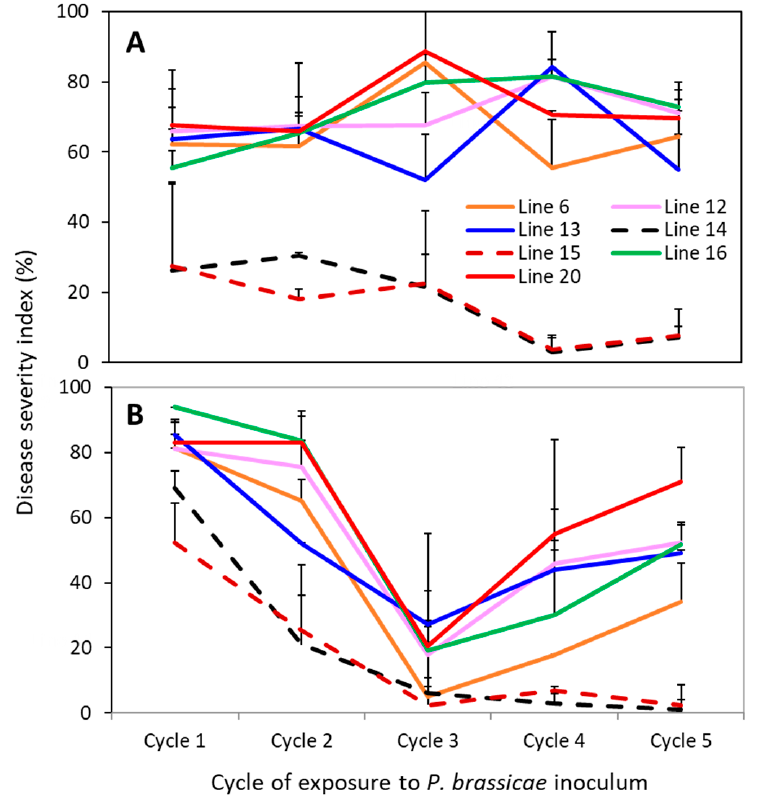
Figure 3. Mean clubroot severity (disease severity index, DSI) on seven selected canola lines carrying different numbers/combinations of CR genes in response to L-G3 of pathotype X in five planting cycles of repetitions 1 ( A ) and 2 ( B ) of the study. The lines 14 ( Rcr1 + Crr1 rutb ) and 15 ( CRa M + Crr1 rutb ) were moderately resistant (in dash lines), while the rest were susceptible (in solid lines).